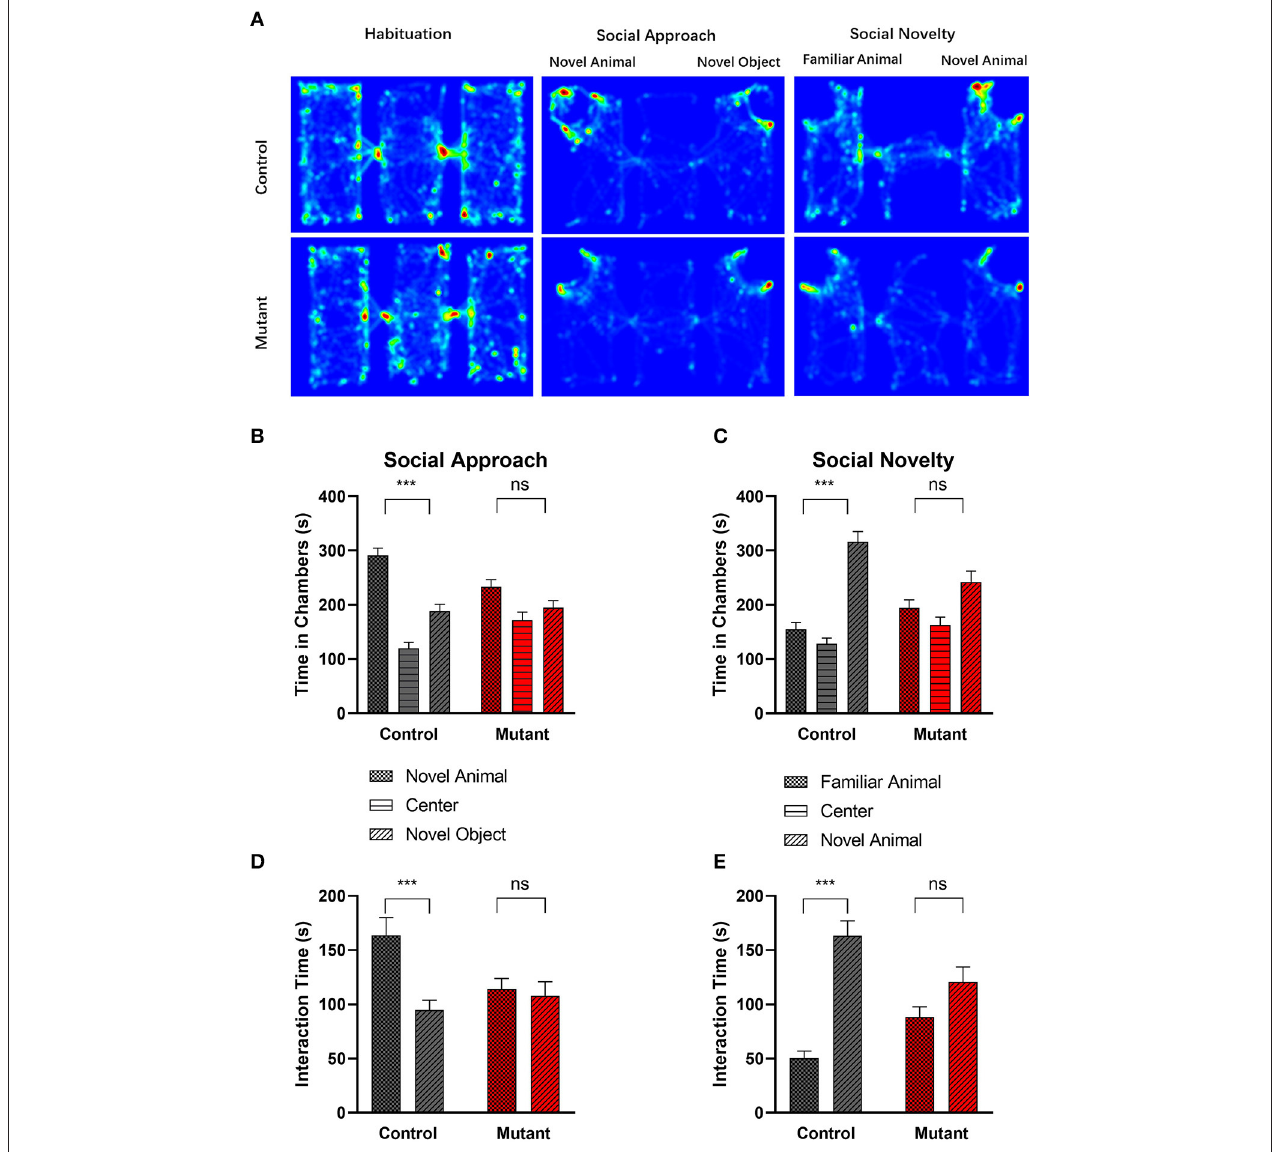
FIGURE 5 | Abnormal social behavior in PC Scn8a mutant mice. (A) Representative heat maps showing time spent by Control mice (upper panel) and PC Scn8a mutant mice (lower panel) at each location of the three-chambered apparatus during the test. (B,D) In the social approach test, WT mice spent more time in the chamber with the stranger animal than in the chamber with the inanimate object (B) , and spent more time interacting with novel animal (D) in comparison with a novel object, whereas PC Scn8a mutant mice show no preference. (C,E) PC Scn8a mutant mice show no preference for the chamber with the novel animal in comparison with that with a familiar animal in an assay of social novelty (C) , and spent similar time interacting with both the novel and familiar animals (E) . This is in distinct contrast to control mice. Control: n = 16; Mutants: n = 17, *** P < 0.001, two-way ANOVA, Bonferroni’s post-hoc analysis.